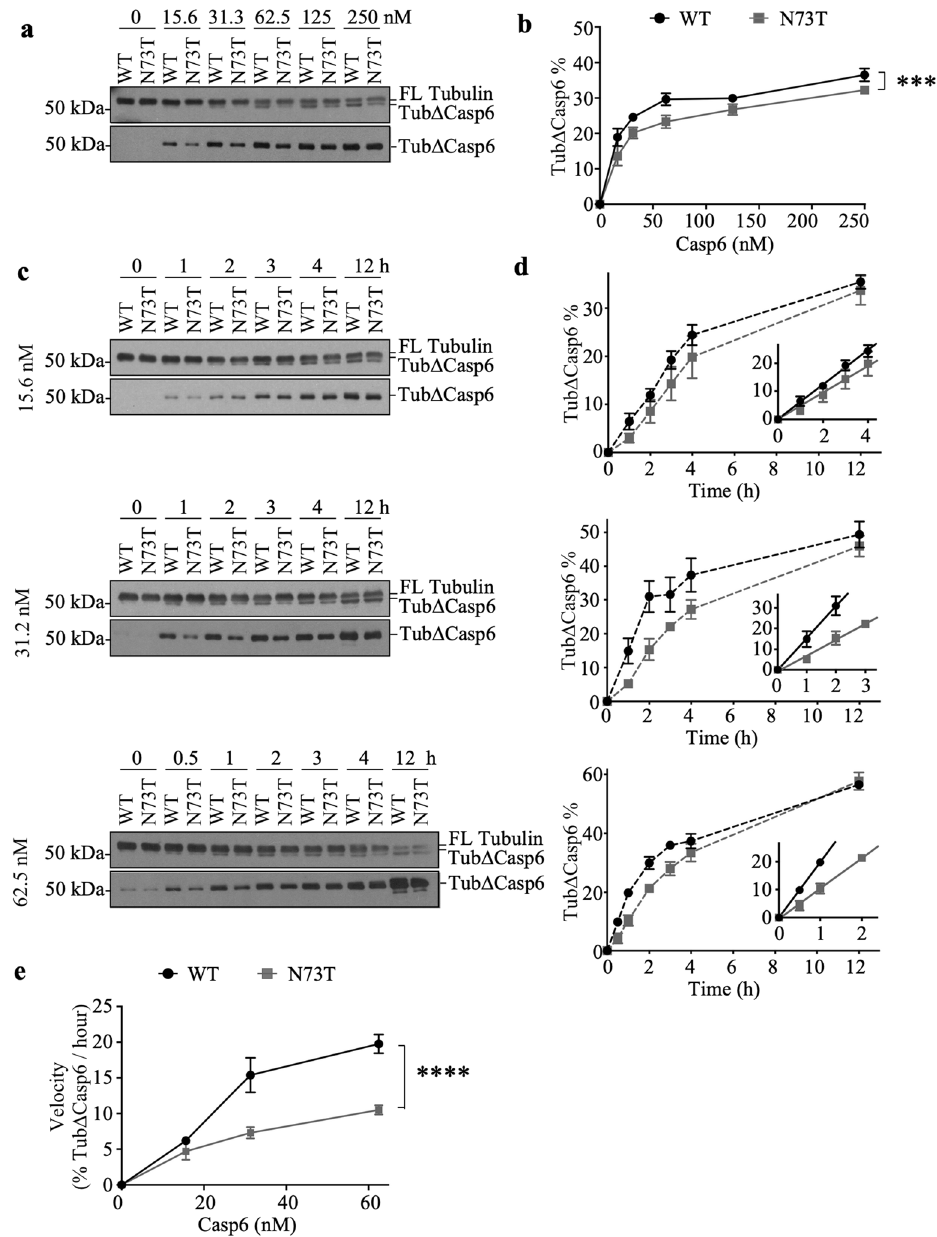
Figure 5. Casp6WT and Casp6N73T enzymatic processing of α-Tubulin. ( a ) Western blot of full-length (11H10 Cell Signaling Technology; top) or cleaved α-Tubulin at VGVD438 (GN20622; bottom) in the reactions of 15.6–250 nM recombinant Casp6WT or Casp6N73T with 242 nM of purified α- and β-Tubulin (121 nM of α-Tubulin). Tub∆Casp6, α-Tubulin cleaved by Casp6. ( b ) Quantification of Tub∆Casp6 shown in (A) expressed as % of FL Tubulin. Statistical evaluations were done with two-way ANOVA (variant: p = 0.0002, concentration: p < 0.0001, interaction: p = 0.4555). Post-hoc analyses were done with Tukey’s test. ***p < 0.001 N73T vs WT. ( c ) Western blot of time-dependent cleaved 121 nM α-Tubulin by 15.6, 31.2, or 62.5 nM Casp6WT or Casp6N73T. ( d ) Quantification of Tub∆Casp6 shown in ( c ) expressed as % of FL Tubulin. Insets: The initial velocity phase of the cleavage curve. The linear regression was performed on % Tub∆Casp6 at 1, 2, 3, and 4 h by 15.6 nM Casp6 (WT: R 2 = 1.00, N73T: R 2 = 0.99), on % Tub∆Casp6 at 1, 2, and 3 h by Casp6WT with 31.2 nM (R 2 = 0.99) or 62.5 nM Casp6WT (R 2 = 1.00), or on % Tub∆Casp6 at 1 and 2 h by Casp6N73T with 31.2 nM (R 2 = 0.99) or 62.5 nM (R 2 = 1.00). (e) Initial velocity of Casp6WT and Casp6N73T reacting on α-Tubulin measured from ( d ). Statistical evaluations were done with two-way ANOVA (variant: p < 0.0001, concentration: p < 0.0001, interaction: p = 0.0015). Post-hoc analyses were done with Tukey’s test. ****p < 0.0001 N73T vs WT. Data represents mean ± s.e.m. from 3 independent experiments. Full-length images of blots/gels are presented in Supplementary